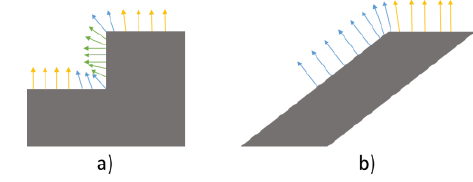
Figure 7. Point adjustment to raster grid: a) points and trajectory vector, b) points in the raster grid without adjustment, c) points rotated in the raster grid